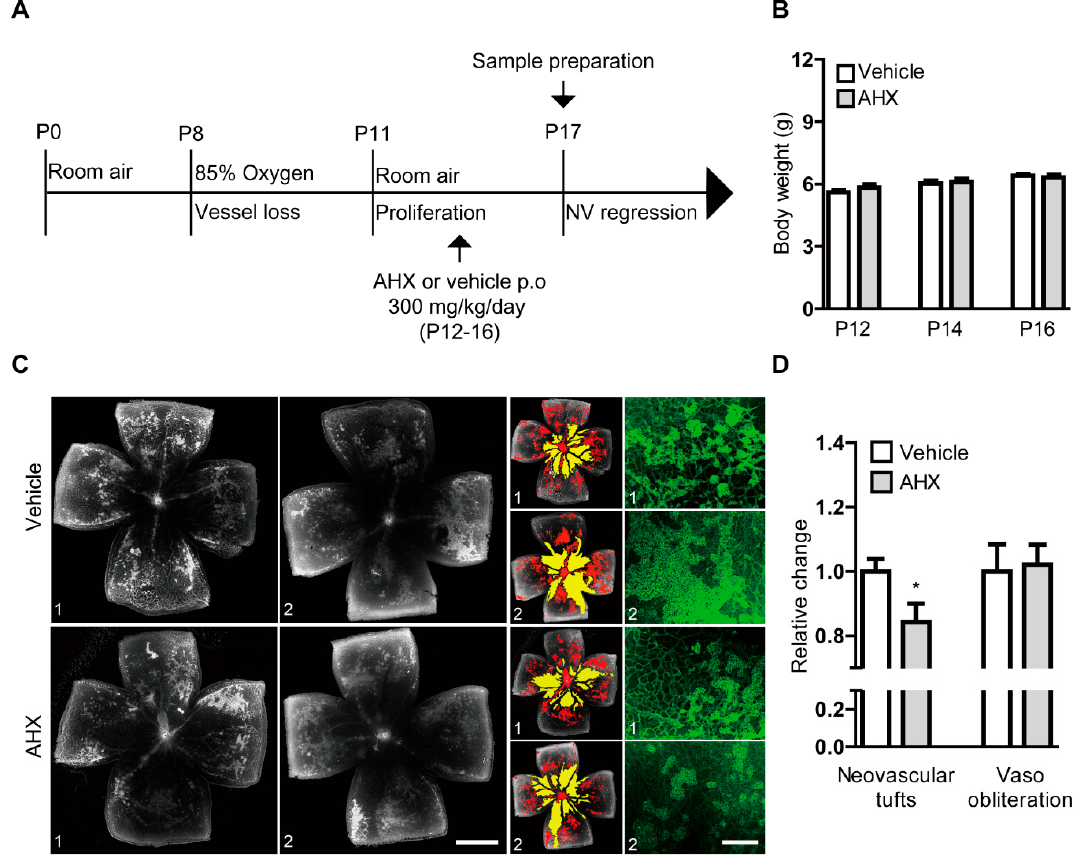
Figure 4. Suppression of neovascularization by oral administration of AHX. ( A ) The schematic illustration shows the murine OIR model procedure and the oral administration of the AHX or vehicle to mice. ( B ) Quantitative analyses for body weights of the mice ( n = 5–6 per group) showed that the average body weights of the AHX-administered group (three male and three female pups) did not significantly differ from those of the vehicle group (three male and two female pups) during the administration period. ( C ) Representative images of retinal vascular whole mount (vehicle 1, 2 and AHX 1, 2) staining with isolectin B4 (neovascular tufts: red and vaso-obliteration: yellow), and higher-magnification images (green) for neovascular tufts. Scale bars are 1000 and 200 µm, respectively. ( D ) Quantitative analyses showed that areas of neovascular tufts (red) were suppressed in the AHX-administered group ( n = 6) in comparison with those in the vehicle-administered group ( n = 5), while no significant difference in vaso-obliteration (yellow) was observed between the groups. * p < 0.05. Bar graphs were presented as mean with ± standard error of the mean. The data were analyzed using a two-tailed Student’s t -test.